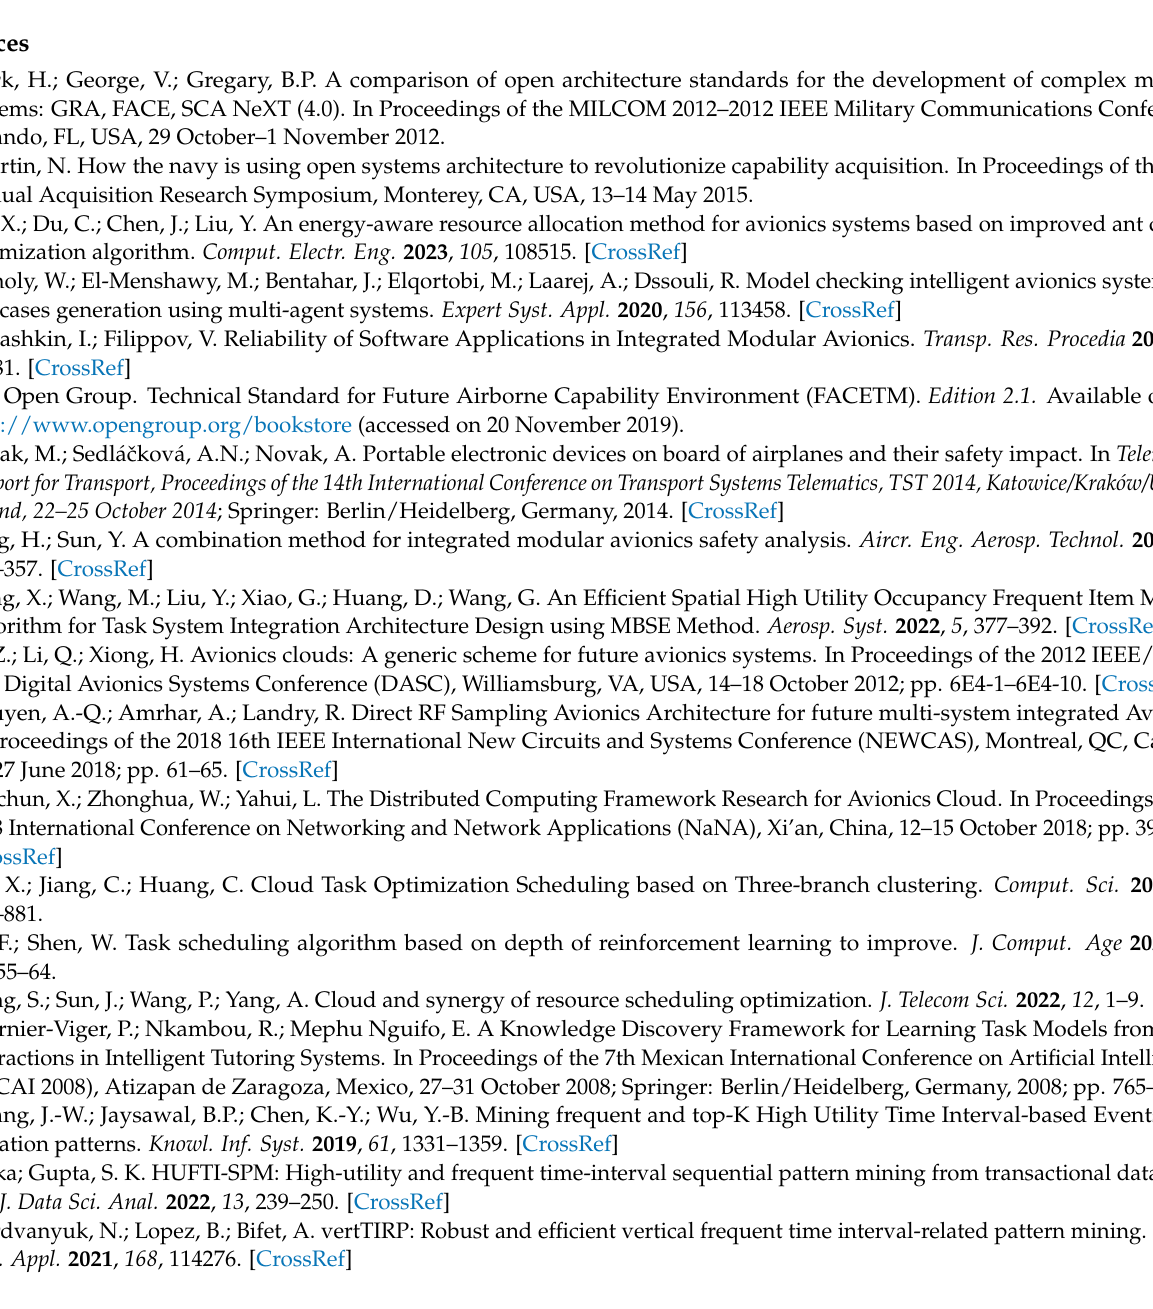
algorithm is a promising method for aided decision-making of task execution sequences under Avionics